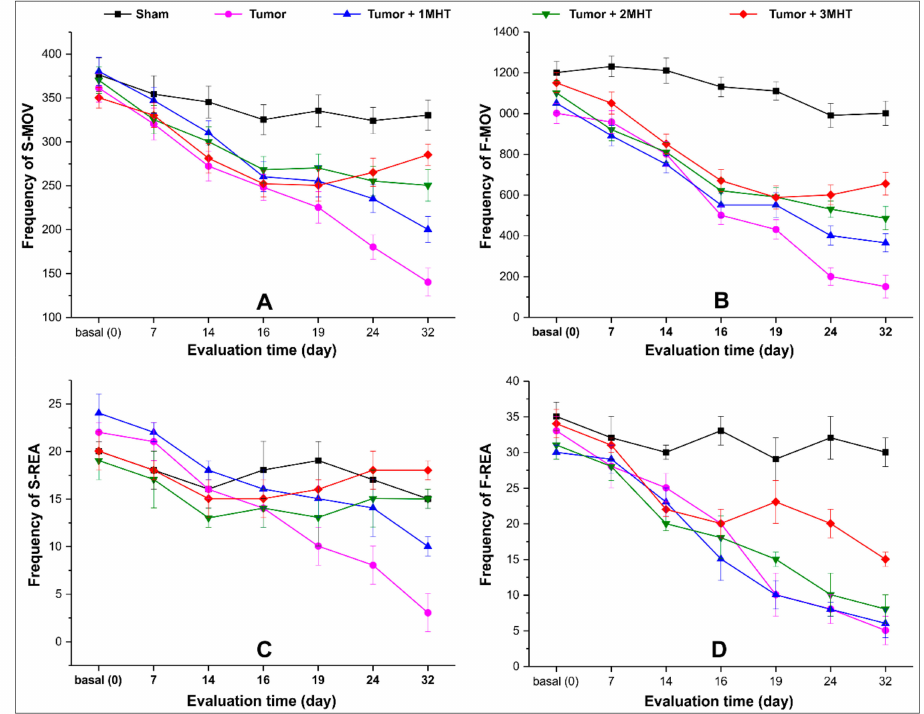
Figure 8. Spontaneus locomotor activity evaluation during multiples MHT applications. ( A ) Slow horizontal moviment (S-MOV), ( B ) fast horizontal moviment (F-MOV), ( C ) slow rearing (S-REA), and ( D ) fast rearing (F-REA), evaluted at 0, 7, 14, 16, 19, 24, and 32